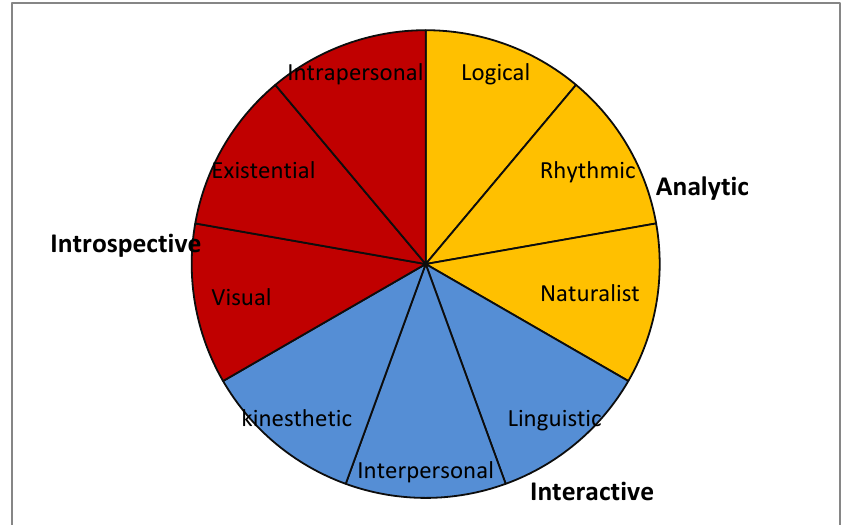
Figure 2.1: Three domains of multiple intelligence (adapted from Gardner, 1999; Gouws 2007, Maftoon &Sarem